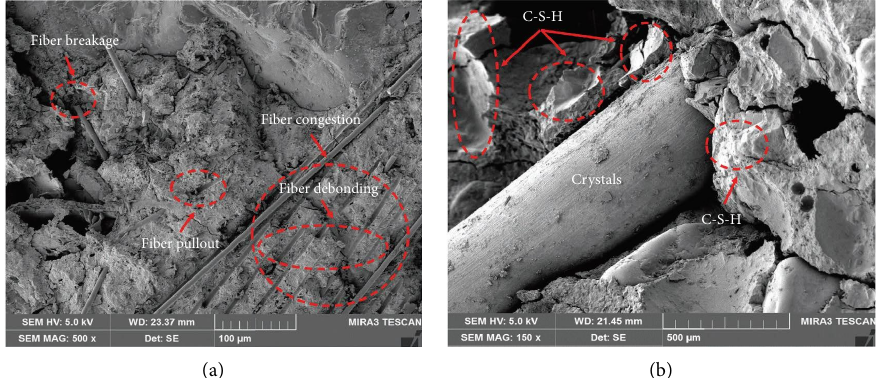
Figure 11: SEM images of CF and SF in cement composites. (a) CF (500x) and (b) SF